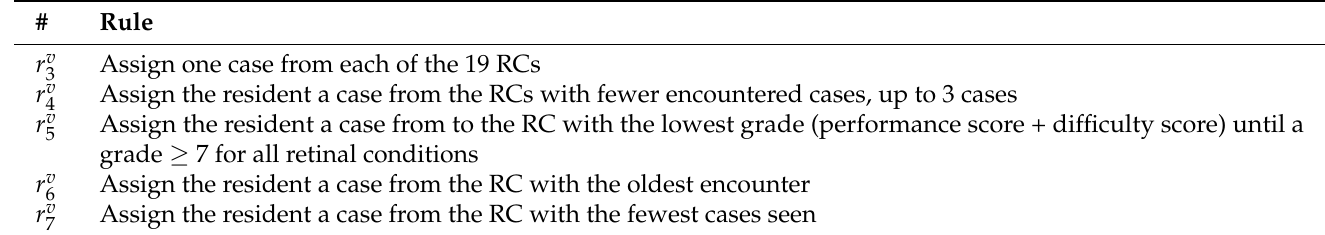
Table 9. Assignment rules for virtual cases.